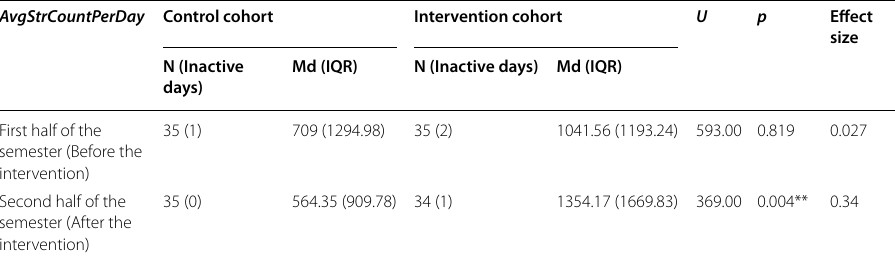
Table 3 Mann-Whitney U-test of AvgStrCountPerDay before and after the intervention compared between two cohorts